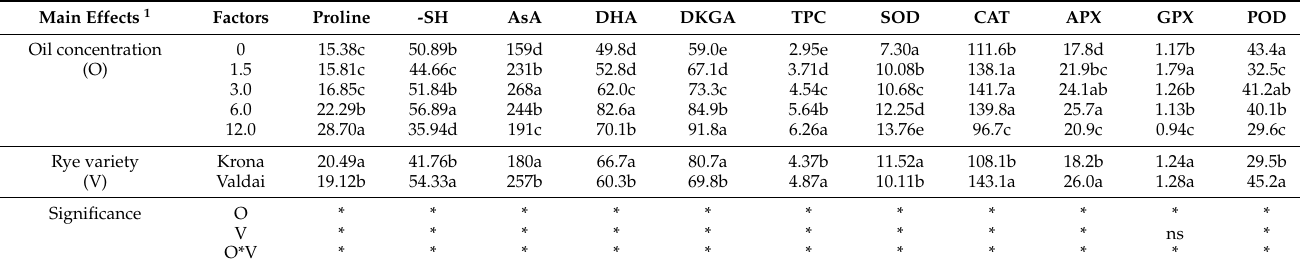
Table A2. Results of two-way ANOVA for non-enzymatic and enzymatic